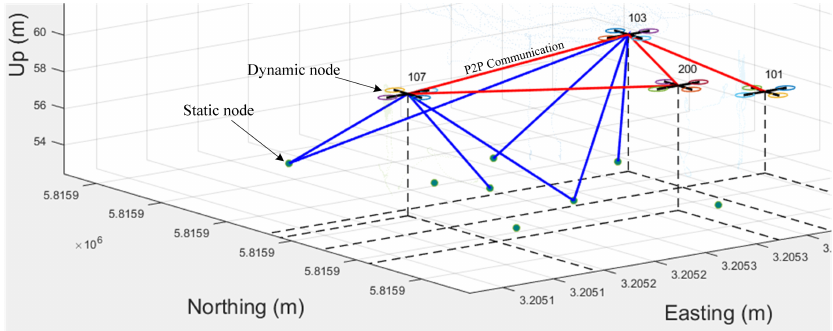
Figure 7. A visual representation of the network geometry at an instant in the developed cooperative swarm